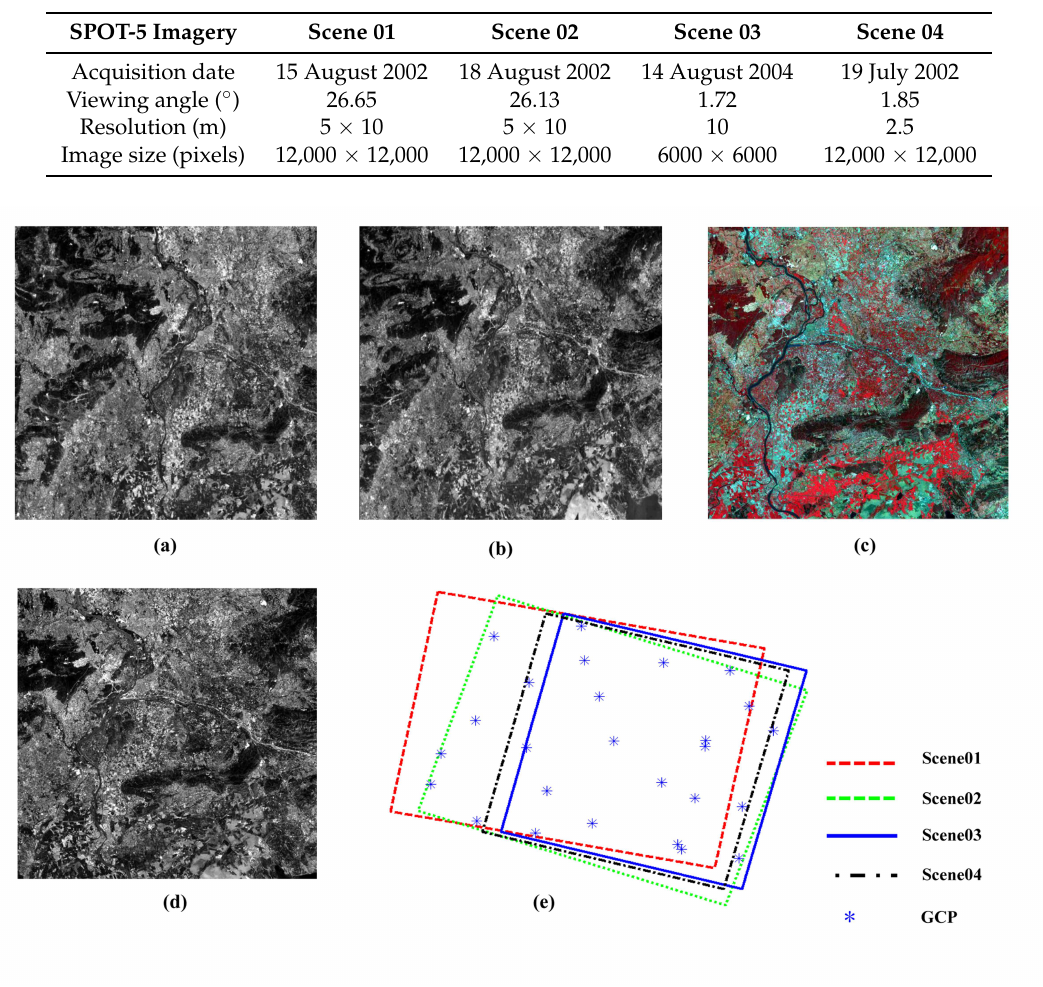
Table 1. Information about SPOT-5 used in the experiment.